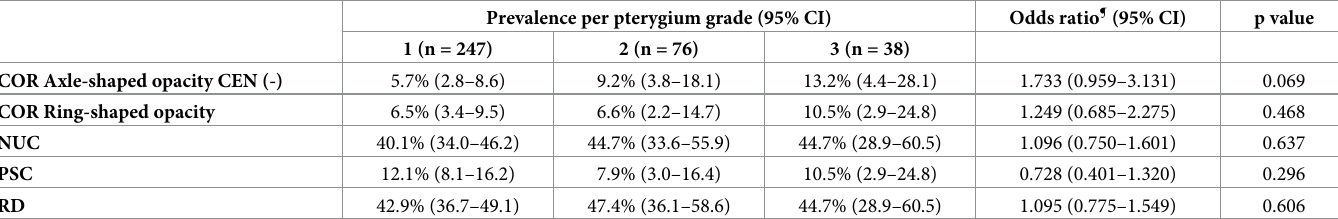
Table 7. Cataract prevalence and risk with increasing pterygium